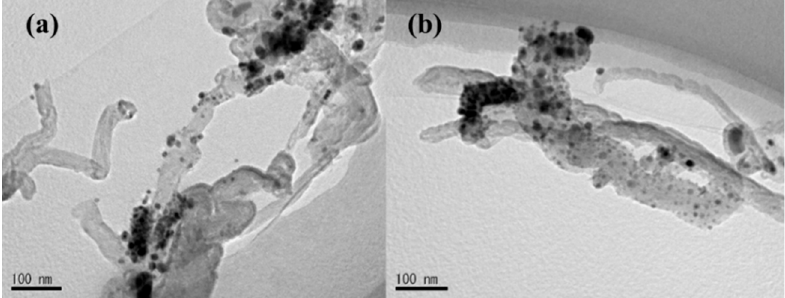
Figure 2. HRTEM of titanium-coated CNTs under the process of magnetron sputtering. ( a ) Ti ‒ CNTs #1 with 40 s irradiation and 42 s DC sputtering. ( b ) Ti-CNTs #2 with 60 s irradiation and 42 s DC sputtering.